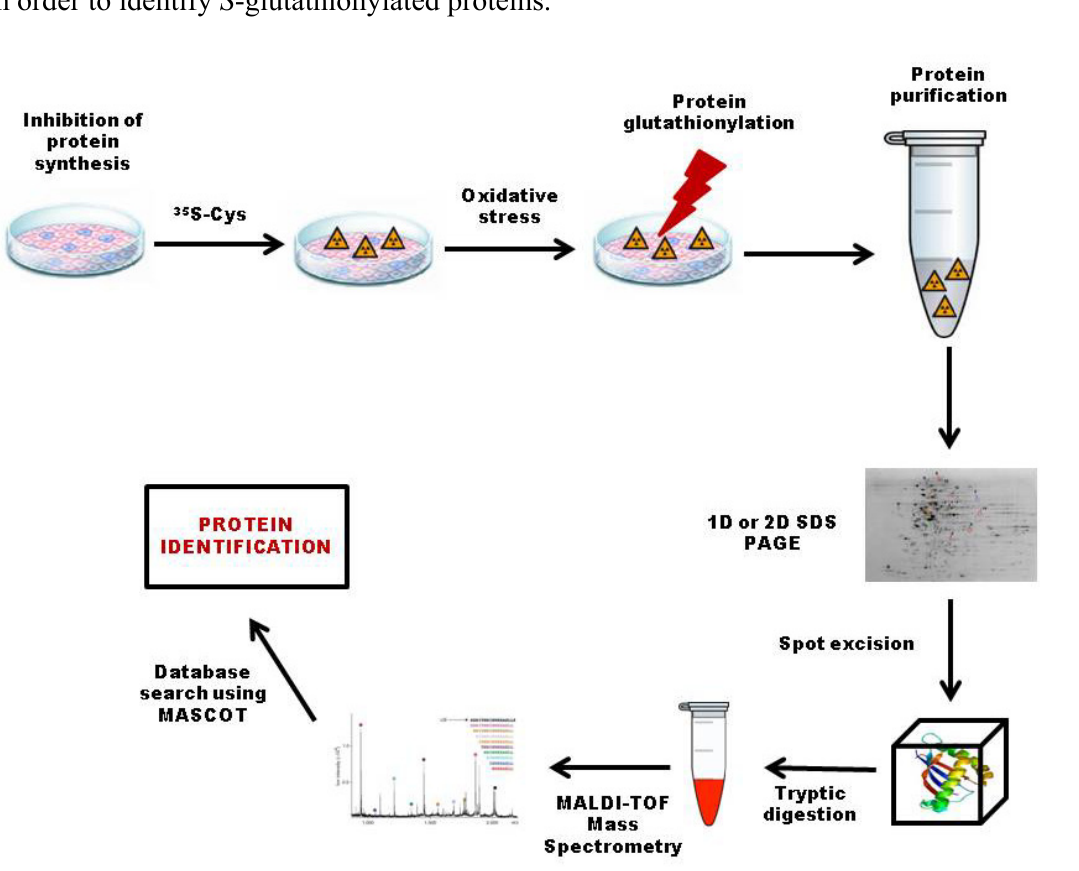
Figure 3. Detection of glutathionylated proteins by 35 S -cysteine labeling. The first step of radiolabeling of the glutathione pool is the inhibition of protein synthesis with cycloheximide, followed by incubation with 35 S -cysteine. 35 S -glutathione is then synthesized by the glutathione cycle. After the initial labeling step, the cells are placed under conditions of oxidative stress, leading to protein S -thiolation. Proteins are then extracted and separated on non-reducing mono- or bi-dimensional sodium dodecyl sulfate polyacrylamide gel electrophoresis. S -thiolated proteins can be visualized by autoradiography, and the radioactive gel spot are excised and digested with trypsin. The resultant tryptic peptides are subjected to matrix-assisted laser desorption/ionization (MALDI-TOF) followed by database searching to identify S -glutathionylated proteins subjected to bottom-up proteomic analysis in order to identify S -glutathionylated